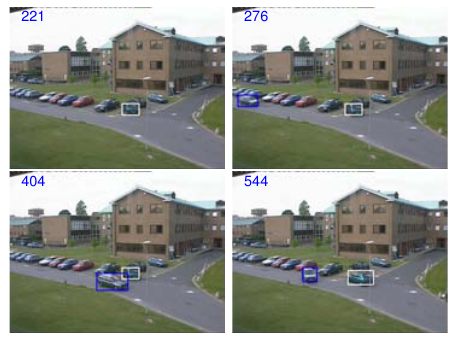
Fig. 10. Results of vehicles detection and